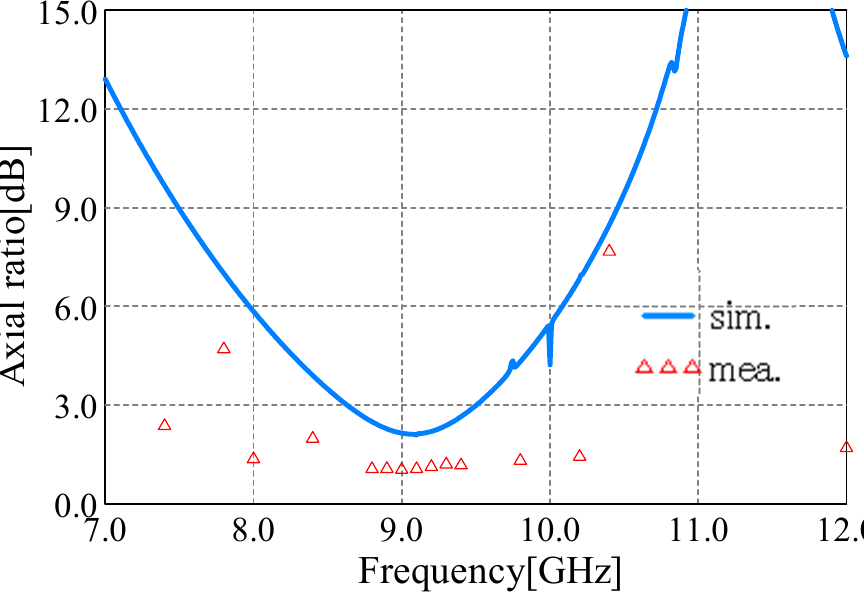
Figure 6. Simulation and measurement results for the axial ratio characteristics.